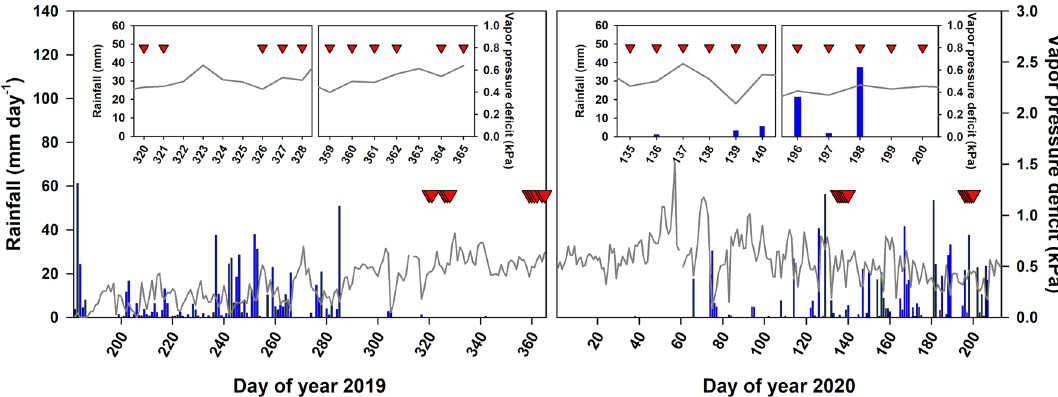
Figure 4. Distribution in rainfall (blue bars) and vapor pressure deficit (VPD, gray line) from 1st July 2019 (day of year 182 in 2019) to 30th July 2020 (day of year 213 in 2020) at Khao Yai National Park, Thailand. Red triangles indicate the sampling days for midday leaf water potential (Ψ md ) measurements. Inset figures are the zoomed-in version of daily rainfall and VPD patterns during the Ψ md sampling